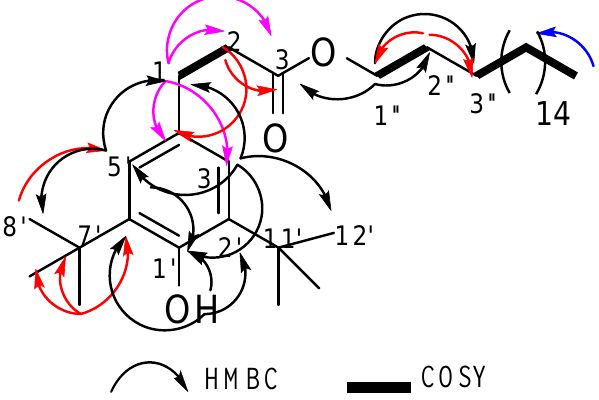
Figure 4. Key correlations for the structural assignment of 2 . Table 2. 1D and 2D NMR data for Compound 2 in CDCl 3 (300 MHz for 1 H-NMR, and 75 MHz for 13 C-NMR).